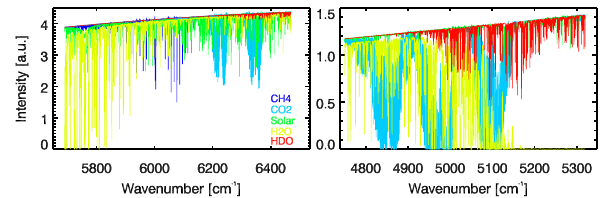
Fig. 1. Overview of absorbers present in the spectral range of GOSAT band 2 (left panel) and band 3 (right panel). The spectra are simulated for a SZA of 30 ◦ and a mid-latitude summer atmosphere. The spectra are shown on the spectral grid of the radiative transfer calculation, and they are not degraded to the spectral resolution of GOSAT.